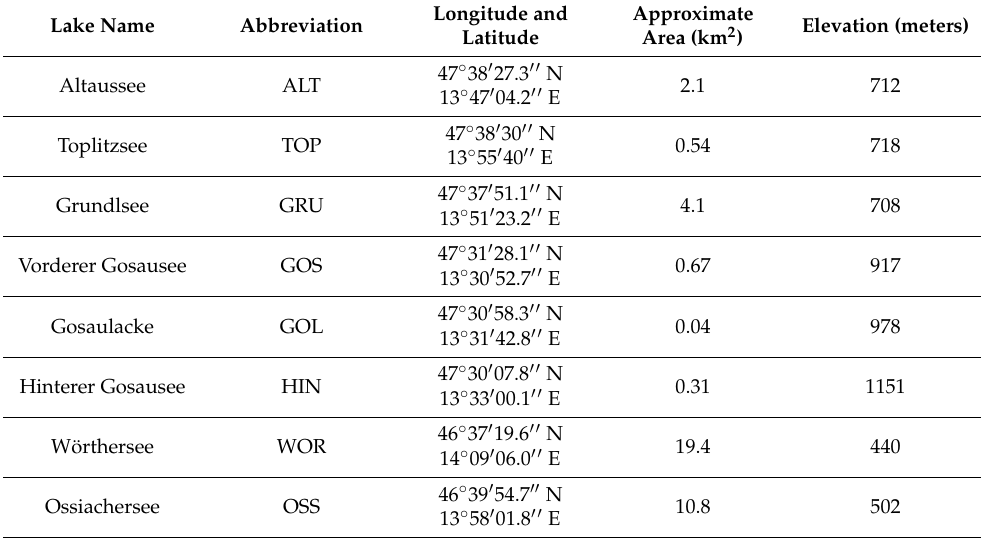
Table 1. Lake name, abbreviation, GPS location, and size, and altitude for all lakes sampled during the